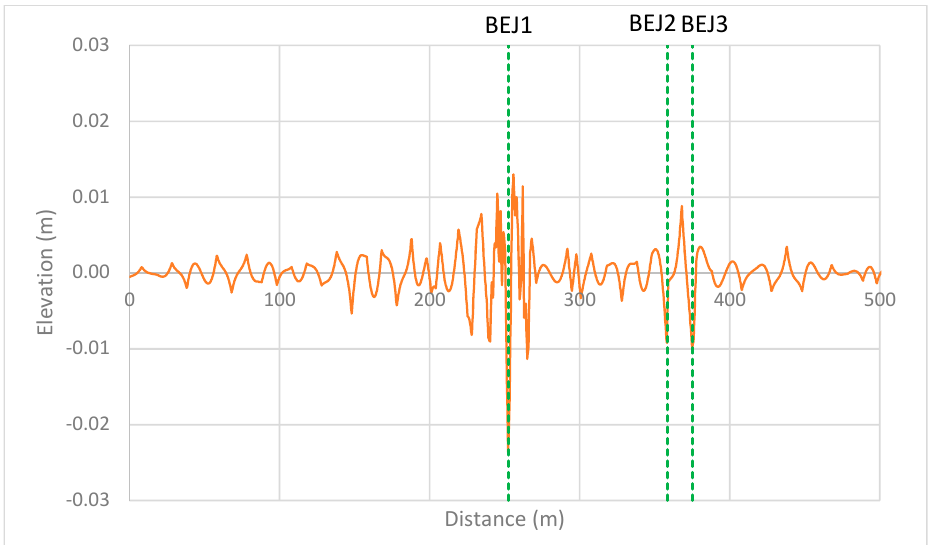
Figure 14. Filtered longitudinal profile: Alignment 2.